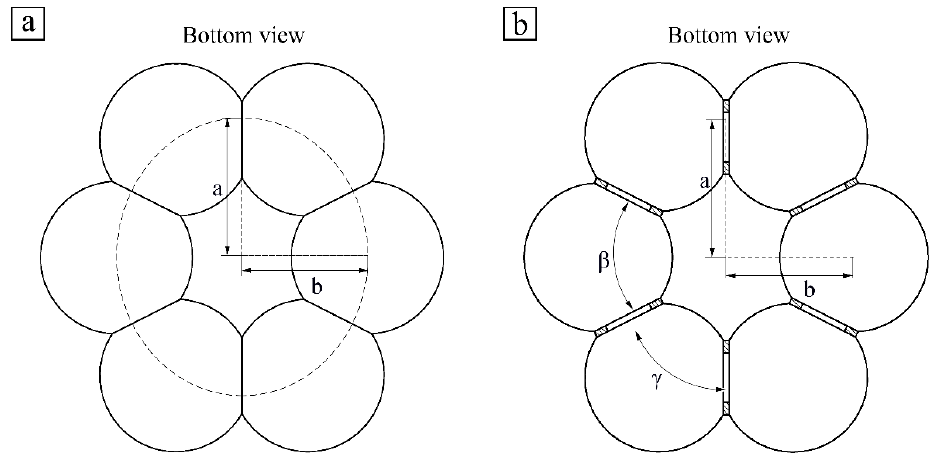
Figure 13. ( a ) Geometric notations for sphere-segmented toroidal shells under the influence of ellipticity. ( b ) Ellipticity parameter definition diagram. Table 5. Geometrical parameters and buckling loads of sphere-segmented toroidal shells with different ellipticities ( K